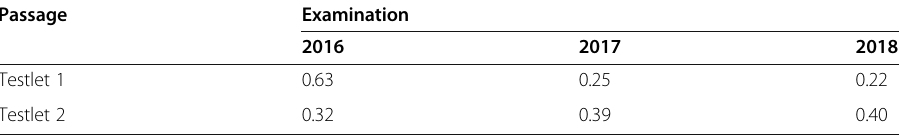
Table 2 Testlet effect variances per EFL reading testlet from the 2016 to 2018 examinations